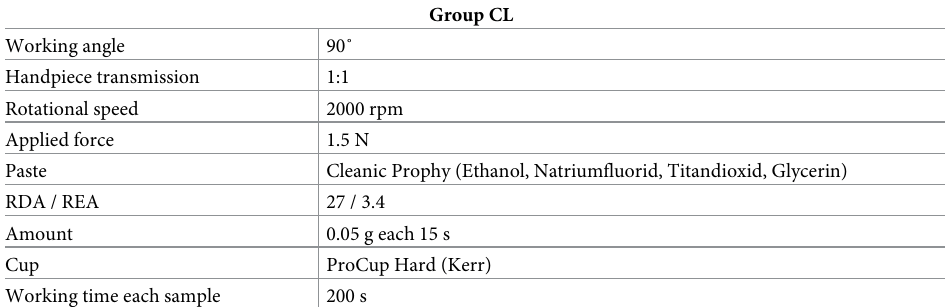
Table 2. Standardized settings for group CL.